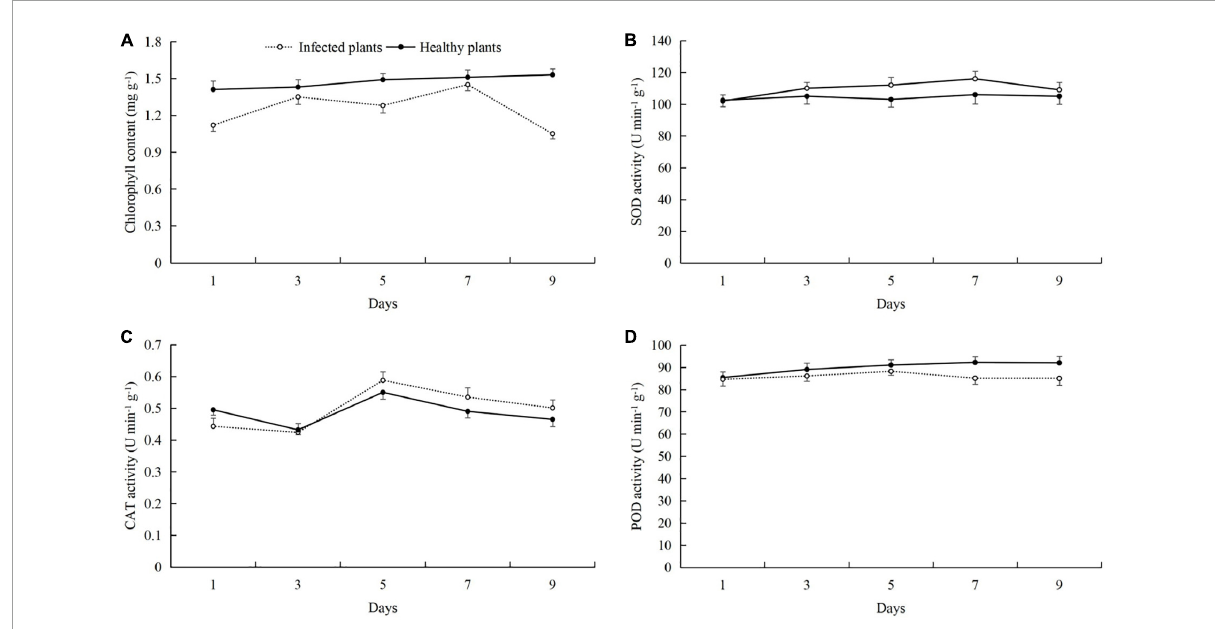
FIGURE1 Effects of powdery mildew infection on (A) chlorophyll content and the activities of (B) superoxide dismutase (SOD), (C) catalase (CAT), and (D) peroxidase (POD) in cucumber